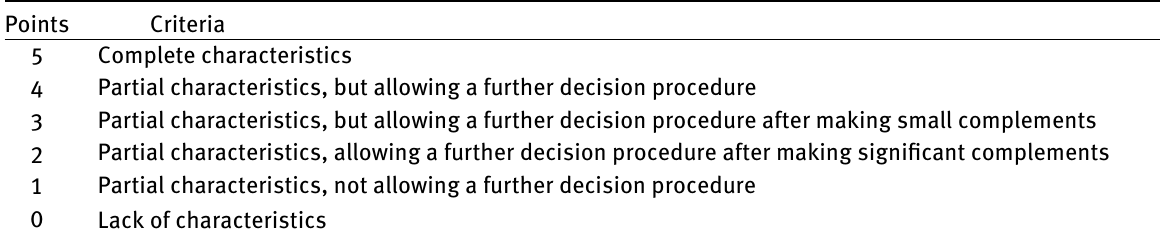
Table 1: Scoring system used in the evaluation of meeting partial criteria. Points